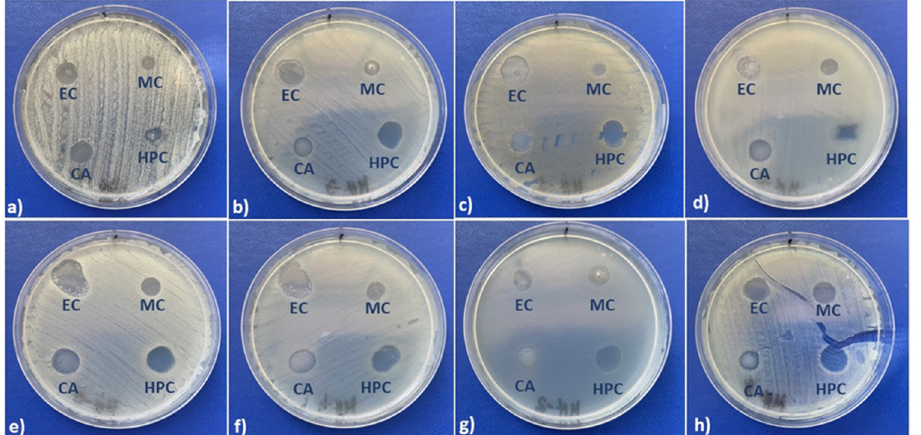
Figure 6. Antimicrobial activity against ( a ) Candida albicans , ( b ) Escherichia coli , ( c ) Mycobacterium smegmatis , ( d ) Staphylococcus aureus methicillin resistant (MRSA), ( e ) Pseudomonas aeruginosa , ( f ) Acinetobacter baumannii , ( g ) Enterococcus faecalis , and ( h ) Stenotrophomonas maltophilia .